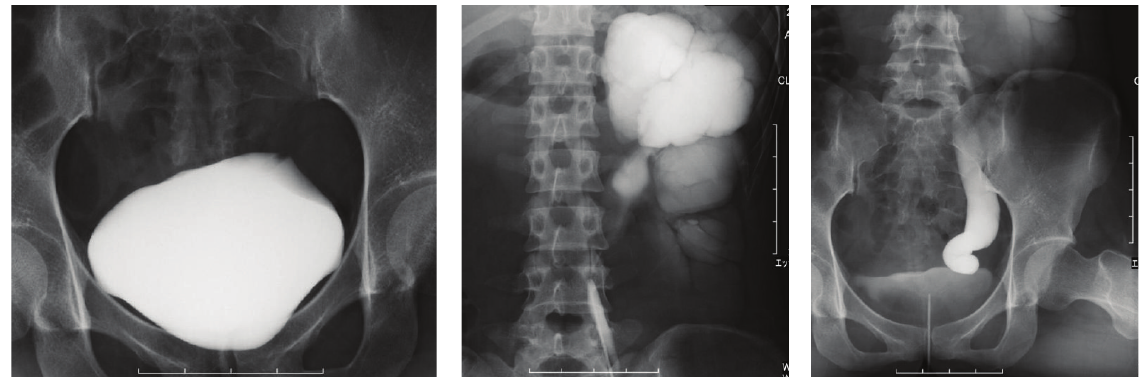
Figure 2: Cystography shows absence of vesicoureteric reflux and retrograde pyelography shows dilated left renal pelvis and full length of ureter.